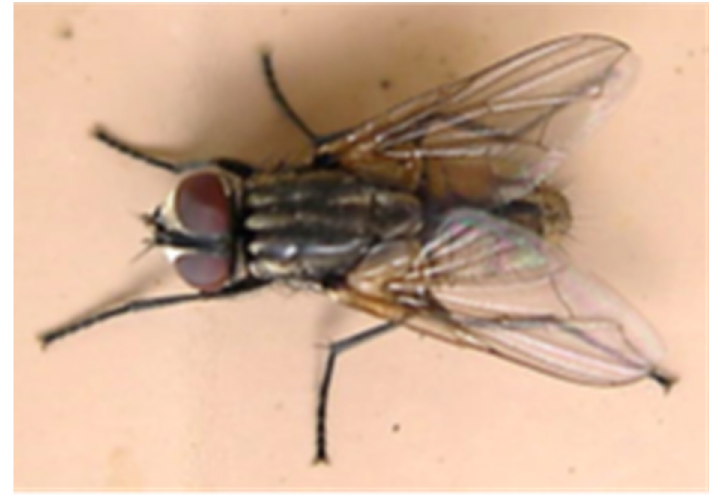
Figure 8. Adult house flies are targeted in urban pest management.